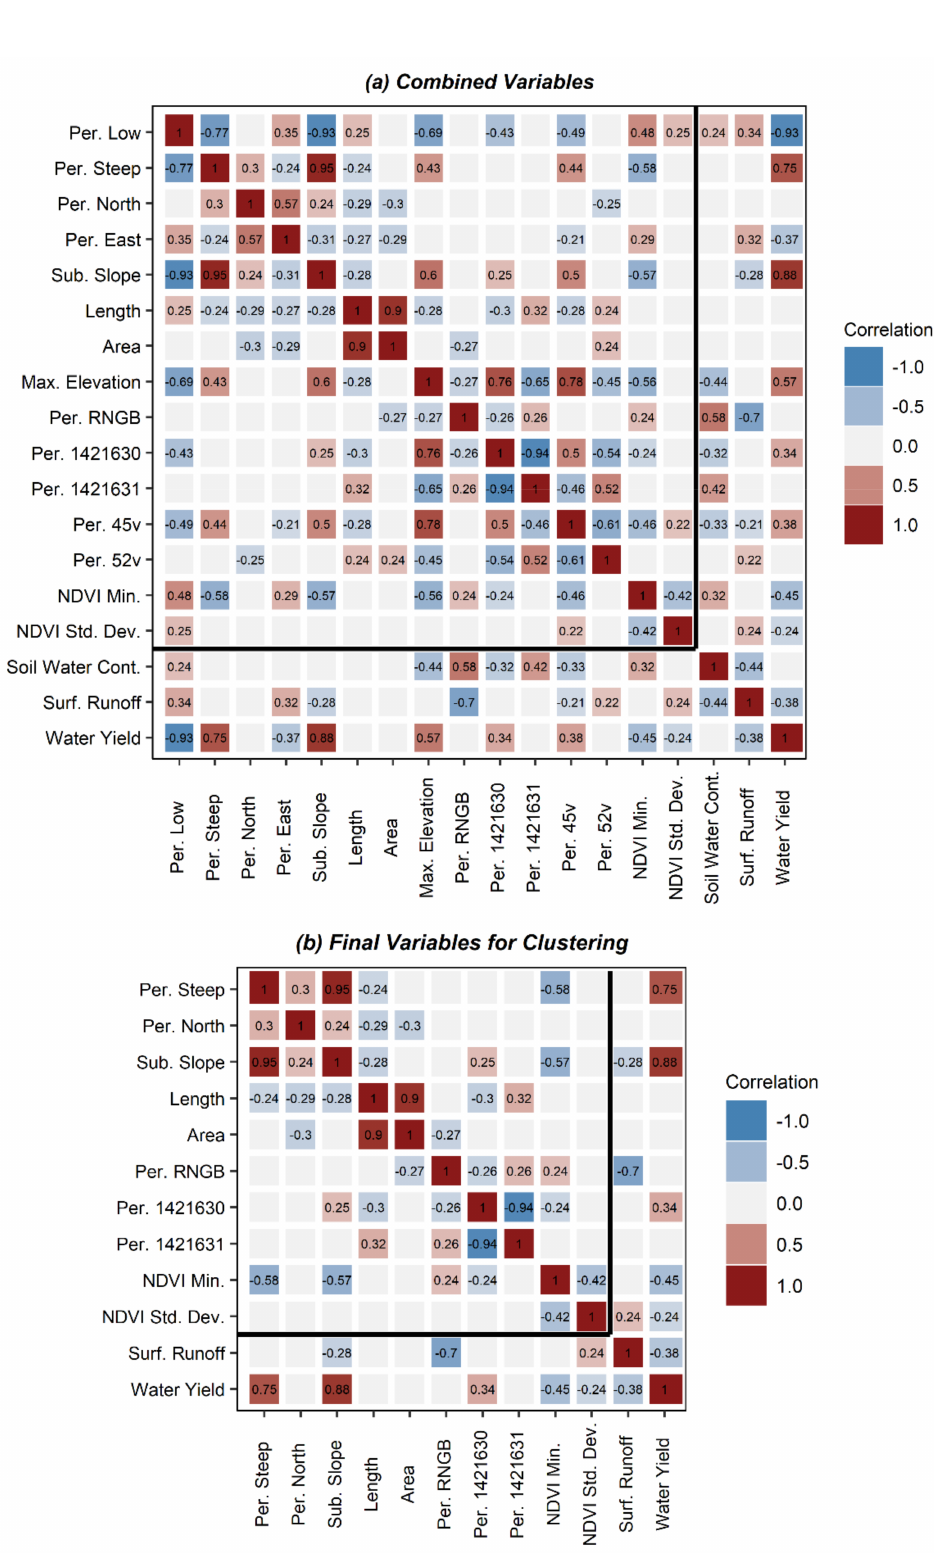
Figure 5. Correlations from − 1 (blue) to 1 (red) for ( a ) the full list of combined variables and ( b ) the final selected variables for clustering. Non-significant correlations ( p -value > 0.05) were removed. For both sets of variable correlations, the hydrologic metrics were separated using black